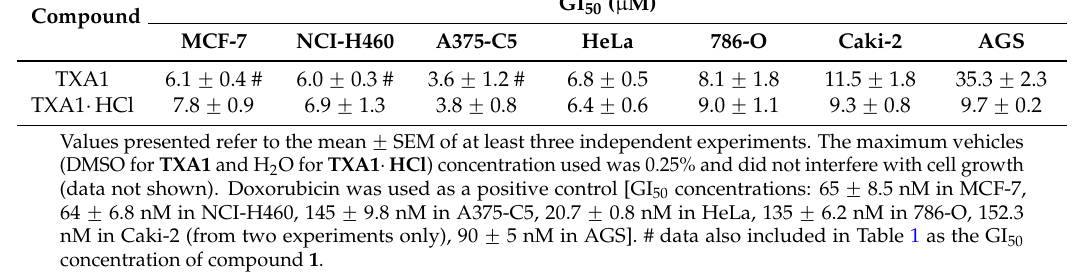
Table 2. GI 50 values determined for the TXA1 and TXA1·HCl in various tumor cell lines derived from solid tumors. Compound